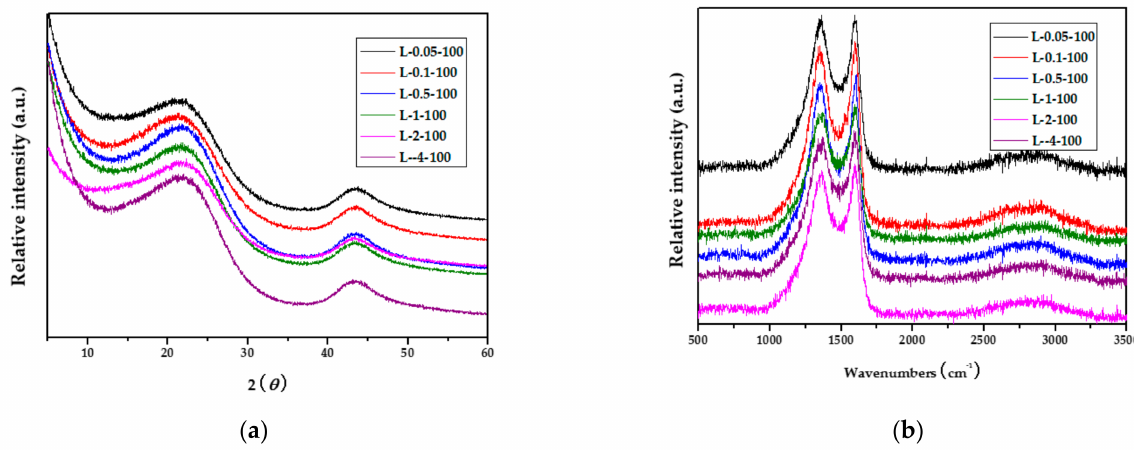
Figure 3. ( a ) XRD profiles and ( b ) Raman spectra of carbon fibers obtained from lyocell fabrics grafted with PAM via